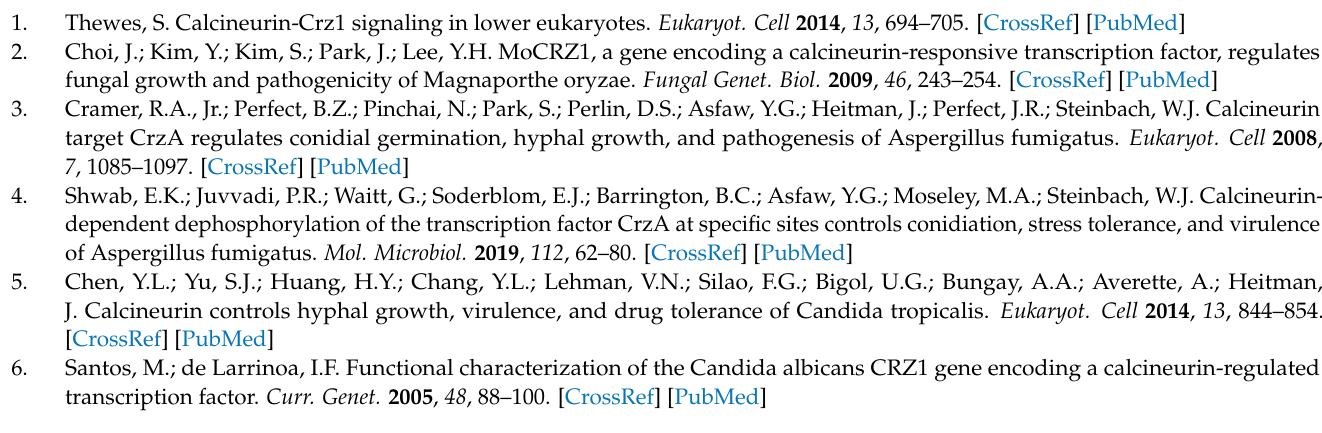
Figure S1: Crz1 cytosolic, nuclear, and granular localization Video S1: Crz1 response to 1 mM Calcium Video: Crz1 response to 1 mM Calcium; Video S3: Crz1 dynamic localization to the bud neck. Reference [37] is cited in the Supplementary